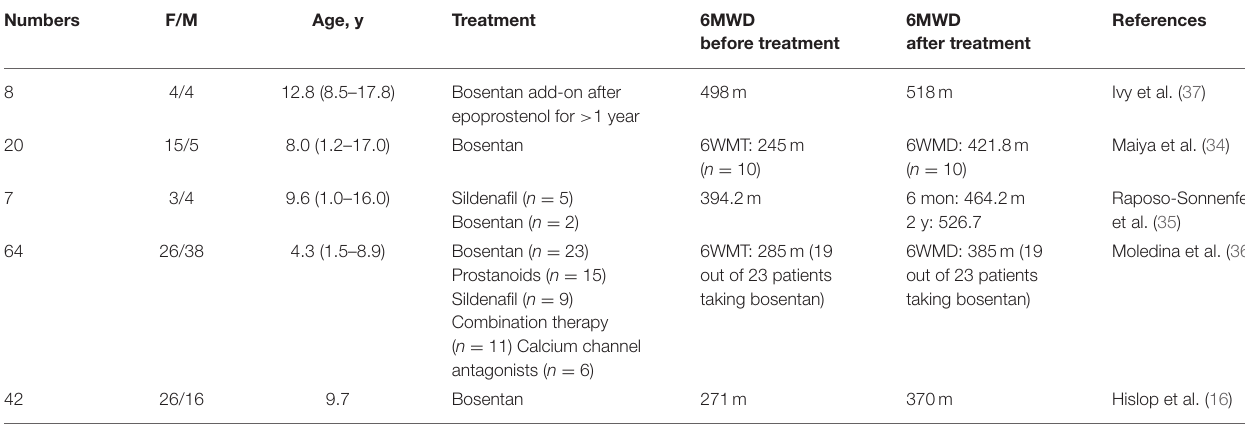
TABLE 1 | Six-minute walking distance (6MWD) of pediatric IPAH patients before and after the treatment of